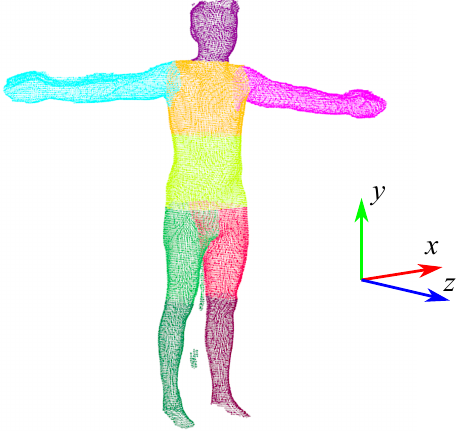
Figure 3. Segmented 3D scan of the human body.